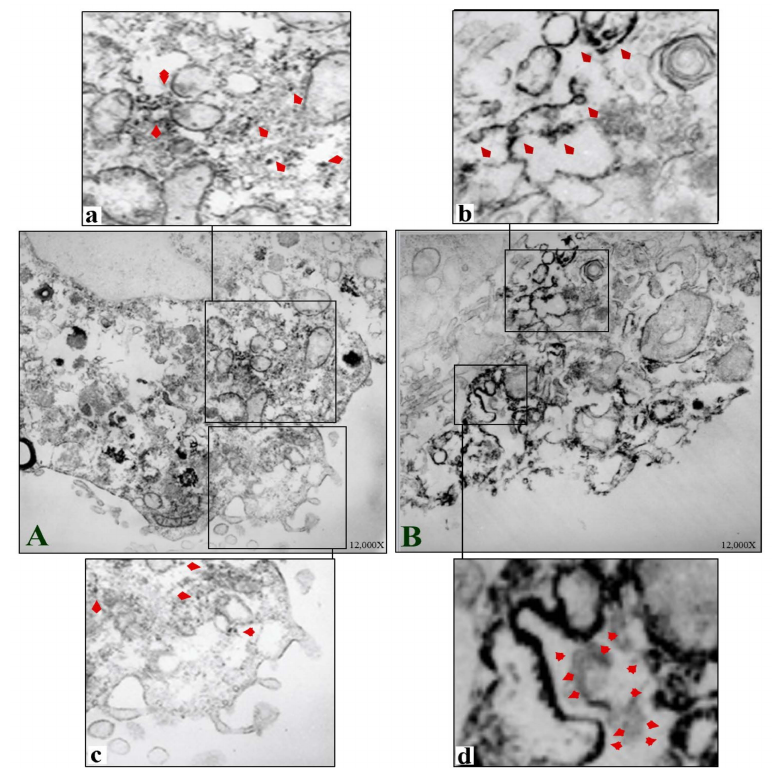
Figure 6. Immunoelectron microscopic images of TOS-1 renal cell carcinoma immunostained for MSGG antigen with mAb-RM1. ( A ) Control TOS-1 cell. ( a ) Cytosolic MSGG antigens non-uniformly scattered with few clusters in a control cell (arrowheads). ( c ) Enlarged view of the control cell with almost negative MSGG membrane expression. ( B ) Shock-wave-treated cell shows immediate integration of MSGG in the membranous structures. ( b ) Incorporation of MSGG antigen in cyto- plasmic vesicles following the shock waves. ( d ) Strong MSGG staining of the cell membrane in the treated cells.